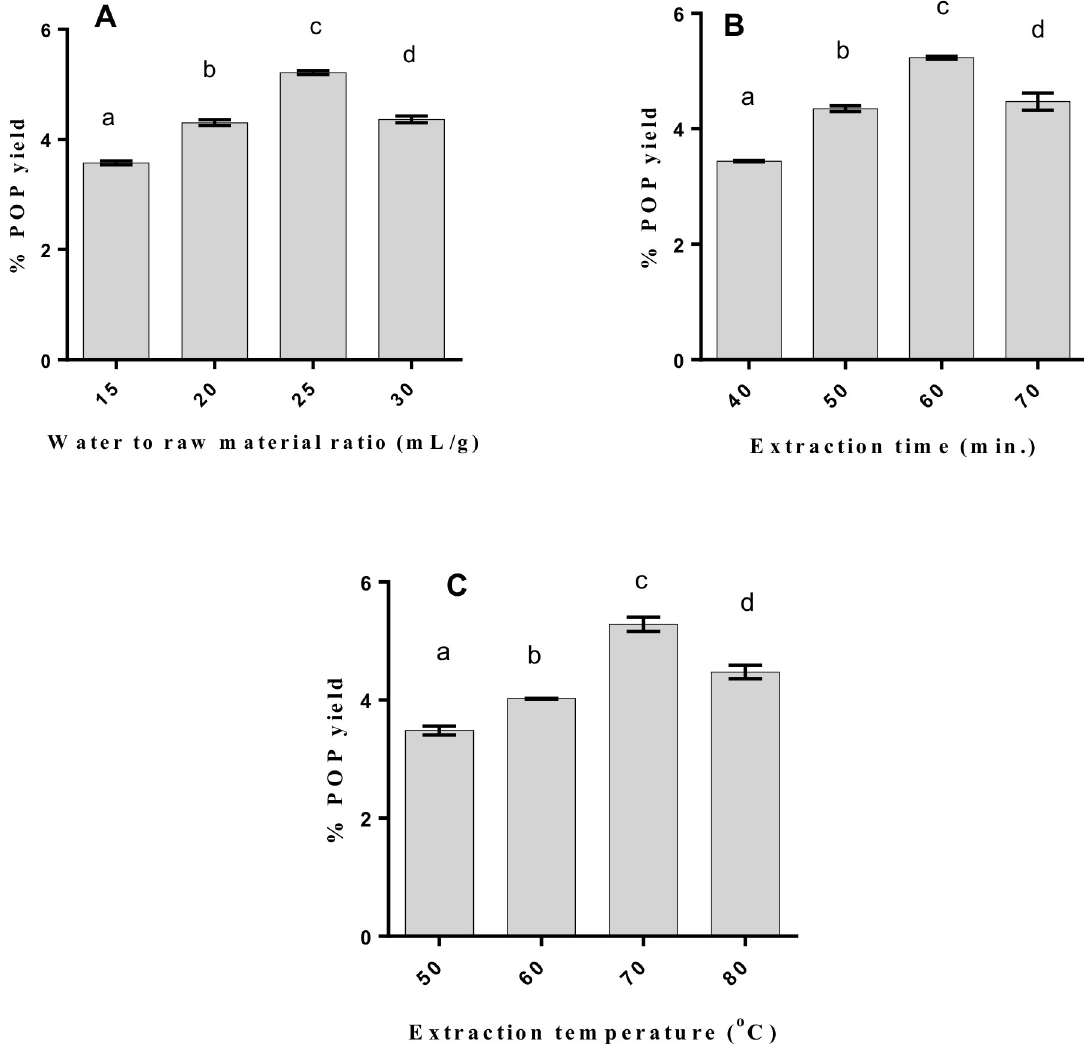
Fig 1. Effect of water to raw material ratio (A), extraction time (B), and extraction temperature (C) on POP yield. Bar charts with different lowercase letters significantly differ (p < 0.05). POP, Pleurotus ostreatus polysaccharide. The % yield of POP increased from 3.57% to 4.36% and increased to 5.21% with an increasing water to raw materials ratio, from 15 mL/g to 25 mL/g. However, when the water to crude material proportion increased to 30 mL/g there was a reduction in the extraction yield of POP. As the water to crude material proportion increased, the disintegration of polysaccharide from the materials essentially increased, and the extraction yield of POP increased. In this way, the water to crude material proportion of 25 mL/g was selected for the BBD